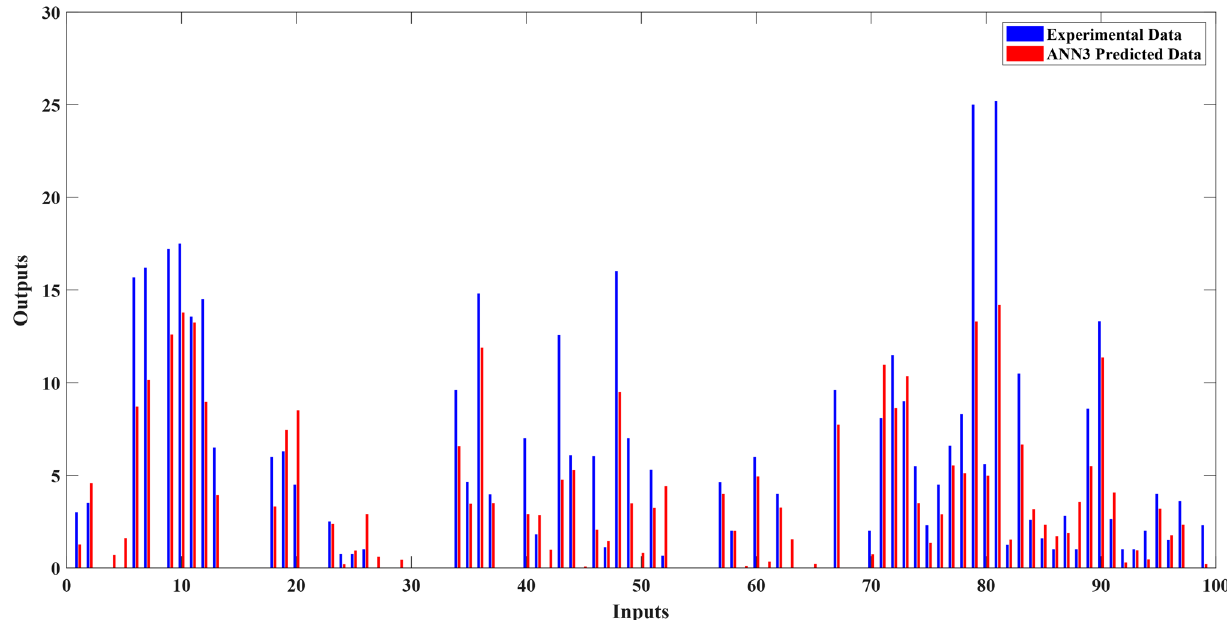
Fig. 28 The performance evaluation of Model No.3 (ANN 3) based on the predicted and experimental data